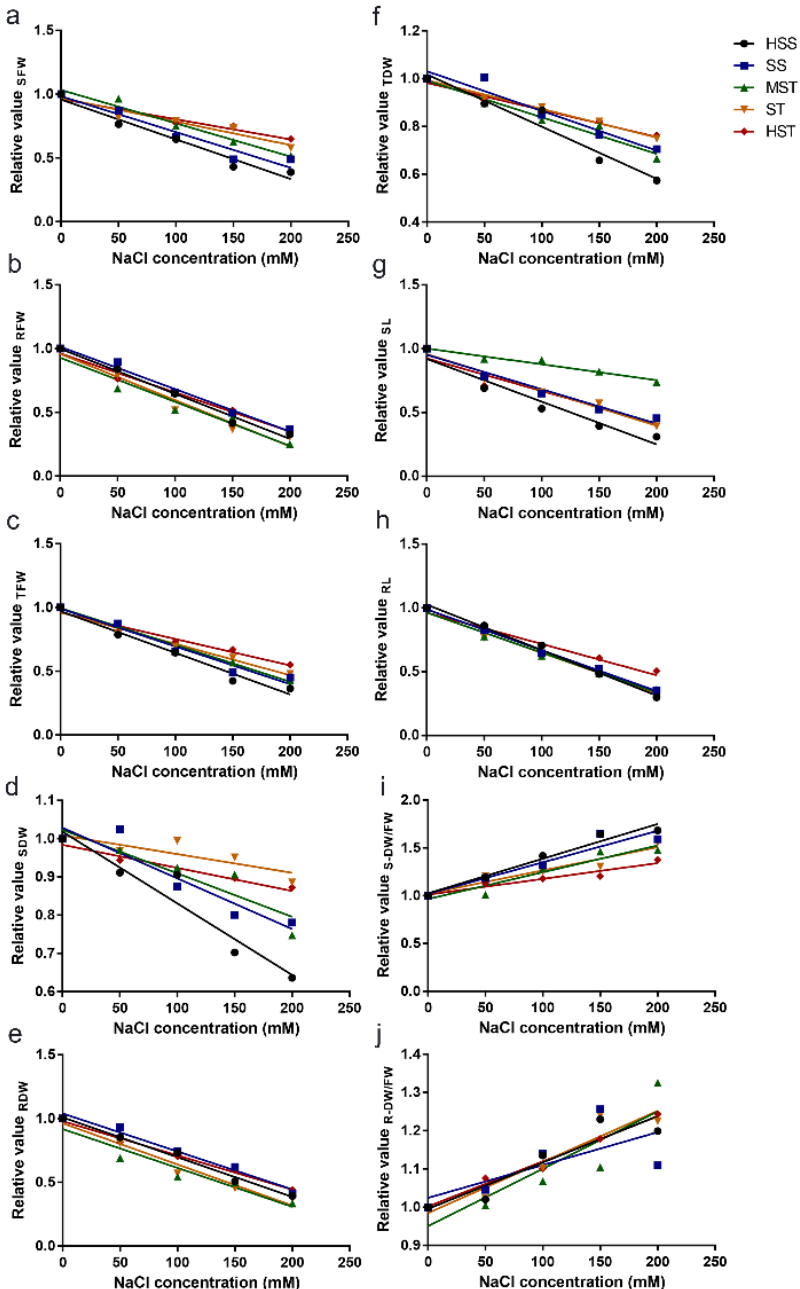
Figure 2. Linear relationship between the NaCl concentration and the relative values of the various growth indicators. The indicators measured were the shoot fresh weight (SFW; ( a )), root fresh weight (RFW; ( b )), total fresh weight (TFW; ( c )), shoot dry weight (SDW; ( d )), root dry weight (RDW; ( e )), total dry weight (TDW; ( f )), shoot length (SL; ( g )), root length (RL; ( h )), ratio of dry weight to fresh weight of the shoots (S-DW/FW; ( i )), and ratio of dry weight to fresh weight of the roots (R-DW/FW; ( j )). Each point represents the mean of four replicates. HSS, high salt sensitivity; SS, salt sensitivity; MST, moderate salt tolerance; ST, salt tolerance; HST, high salt tolerance.